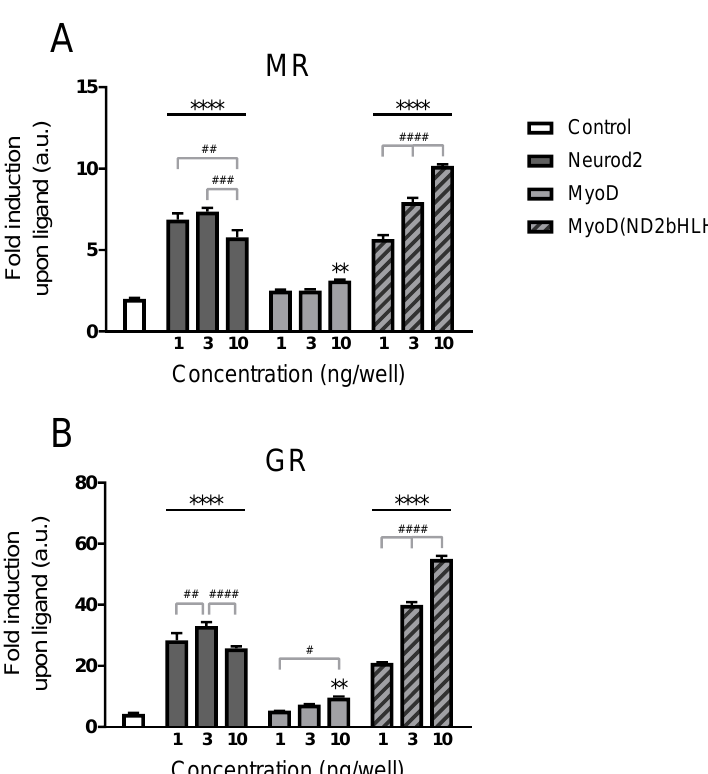
Figure 2. Specificity of NeuroD coactivation at the previously identified binding motif (CAGATG) for ( A ) MR and ( B ) GR. HEK293 cells were transfected with GRE-At_GA luciferase construct, MR or GR (10 ng/well), various amounts of Neurod2, MyoD or the MyoD/Neurod2 chimera (MyoD(ND2bHLH)) (1–3–10 ng/well), and stimulated with corticosterone (10 − 7 M). Data are presented as luciferase activity fold induction upon corticosterone treatment. a.u. = arbitrary unit; ** p < 0.01, **** p < 0.0001 compared to control condition; # p < 0.05, ## p < 0.01, ### p < 0.001, #### p < 0.0001 for within group